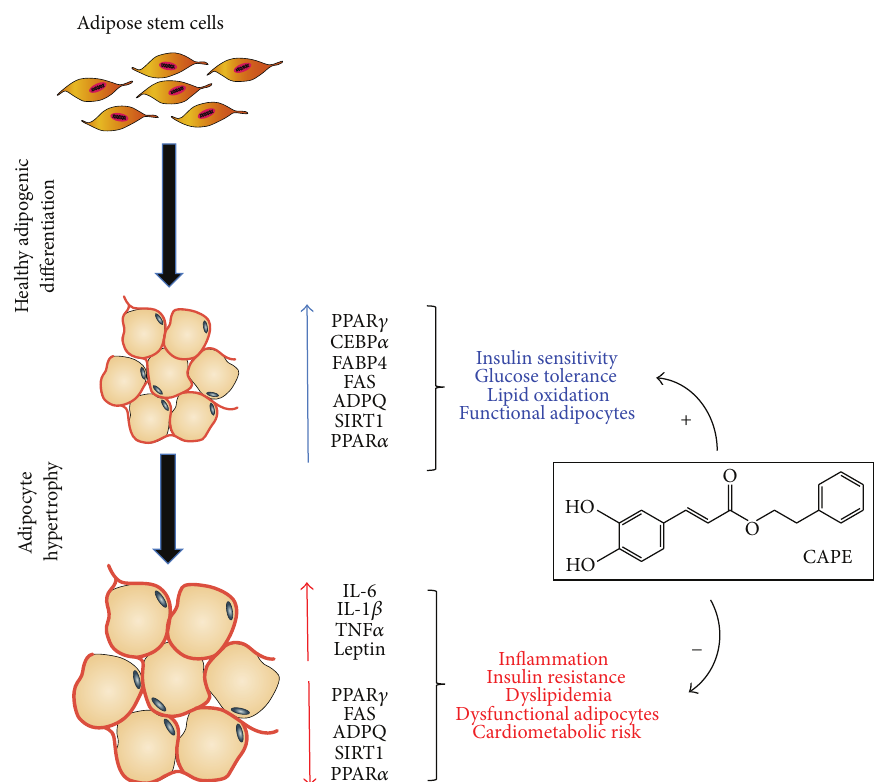
Figure 8: Proposed mechanisms demonstrating the role of Cape in the regulation of ASCs lipid metabolism via induction of PPARs and adiponectin. Cape restores the function of hypertrophic adipocytes by decreasing inflammatory cytokines and increasing insulin sensitive